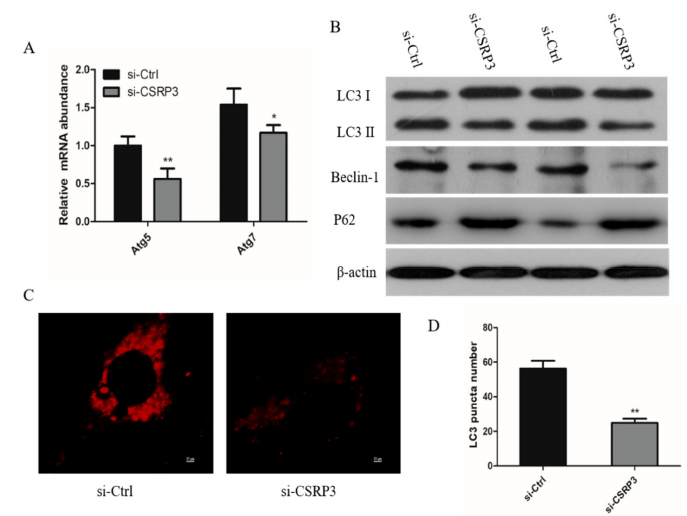
Figure 4. CSRP3 regulates autophagy in chicken myoblasts. ( A ) ATG5 and ATG7 mRNA expression in ctrl or CSRP3 siRNA cells. ( B ) Western blot analysis revealed LC3, P62, and Beclin-1 protein levels in ctrl and CSRP3 siRNA cells. ( C ) Immunofluorescence analysis of cell transfected with ctrl or CSRP3 siRNA then stained with LC3; scale bar = 25 µ m. ( D ) The right diagram shows the average number of LC3 puncta in ctrl or CSRP3 siRNA cells. Data are expressed as mean ± SEM of three independent experiments. * p < 0.05, ** p < 0.01.